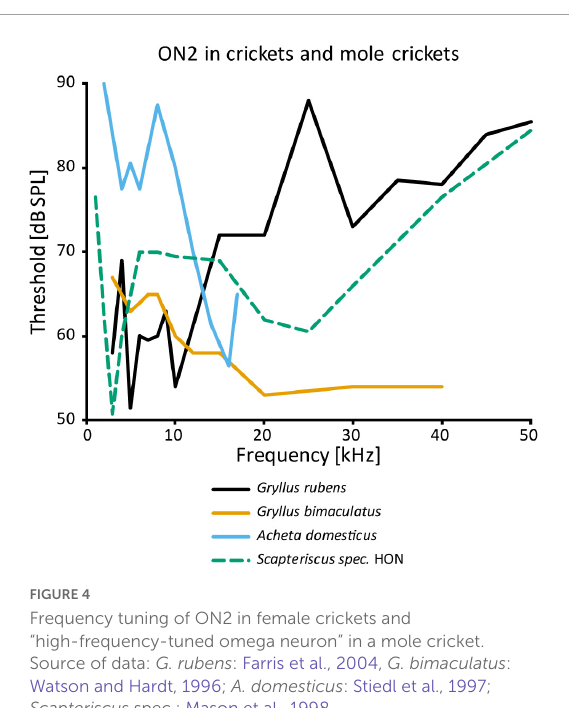
FIGURE4 Frequency tuning of ON2 in female crickets and “high-frequency-tuned omega neuron” in a mole cricket. Source of data: G. rubens : Farris et al., 2004, G. bimaculatus : Watson and Hardt, 1996; A. domesticus : Stiedl et al., 1997; Scapteriscus spec.: Mason et al.,